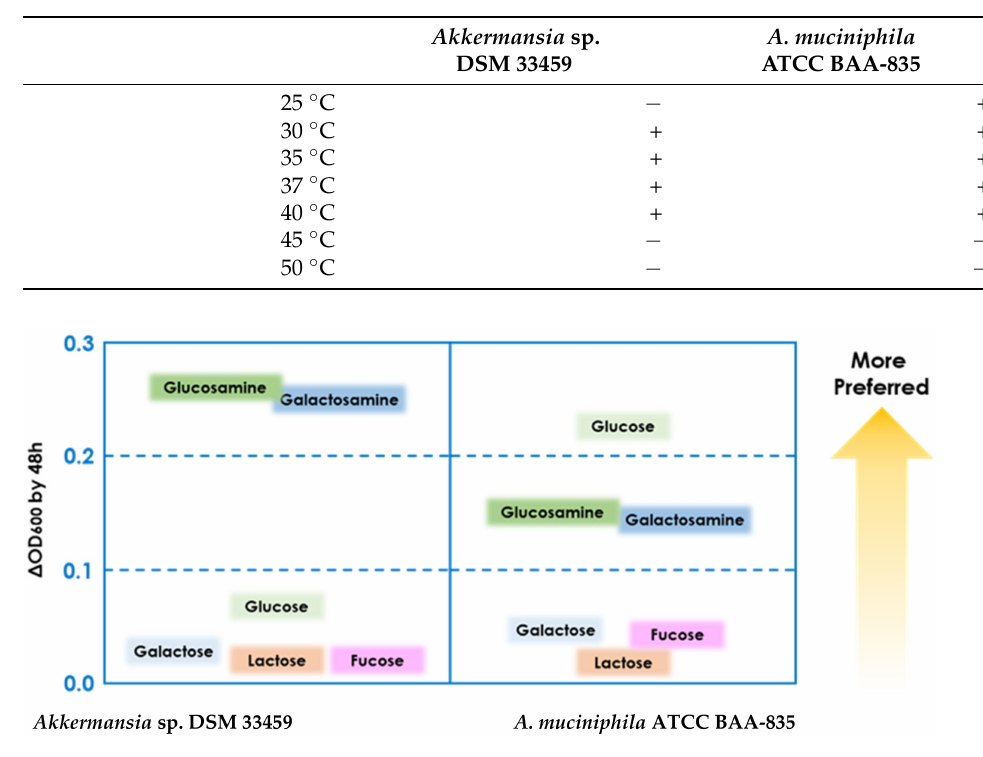
Figure 2. Determination of preferred carbon source for